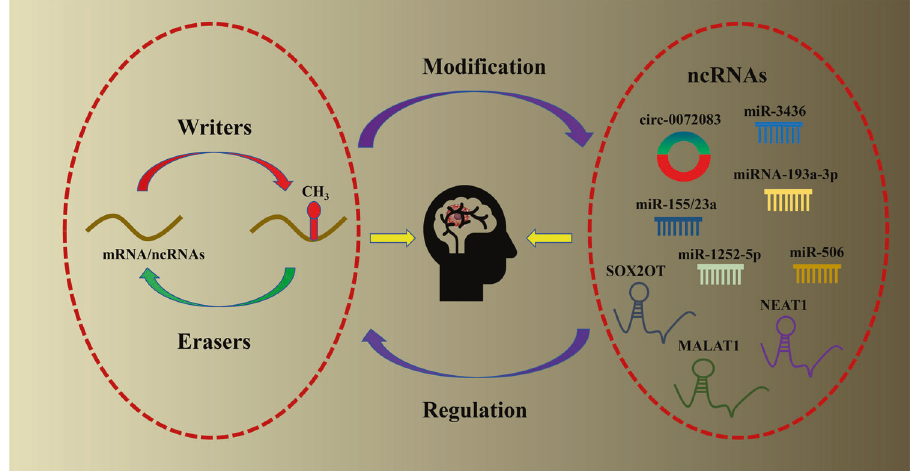
Fig. 2 Mutual regulation between m6a regulator and ncRNAs in glioma. The interaction between m6a regulator and ncRNAs is brie fl y described, and the ncRNAs that play a role in glioma are listed, including lncRNAs, miRNAs and